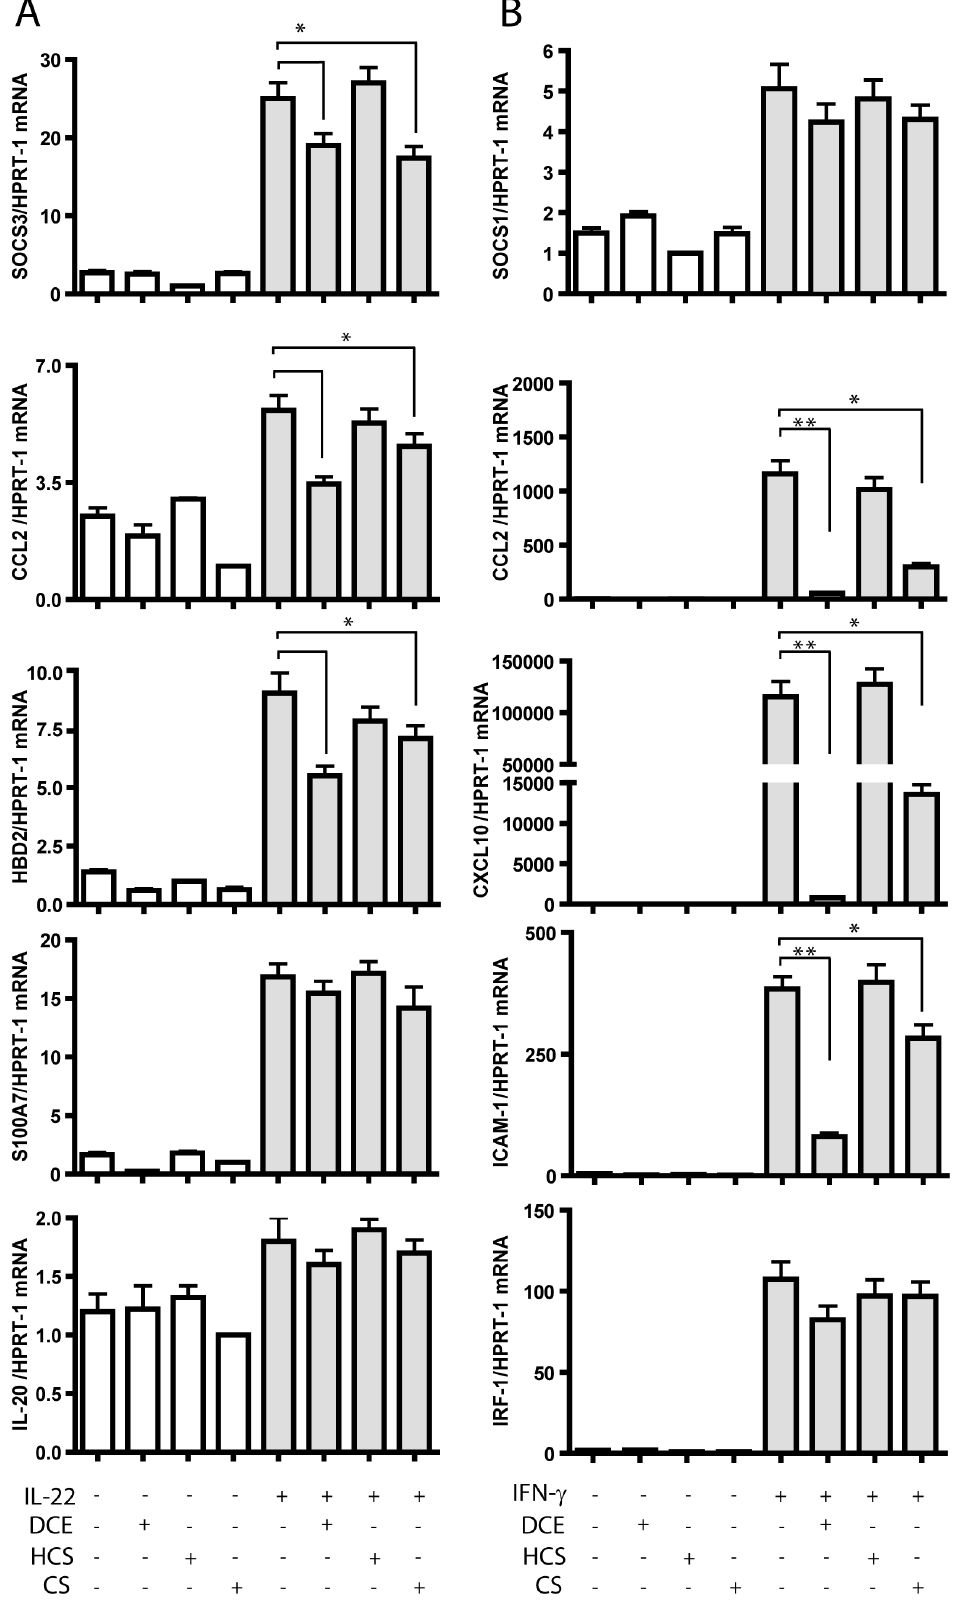
Figure 3. Modulation of the IL-22- and IFN- c -induced gene expression by DCE and CS. The IL-22-induced SOCS3, CCL2, HBD-2, S100A7, IL- 20 mRNA (A) and the IFN- c -induced SOCS1, CCL2, CXCL10, ICAM-1, IRF-1 mRNA (B) expression were evaluated by real-time PCR analysis of RNA from